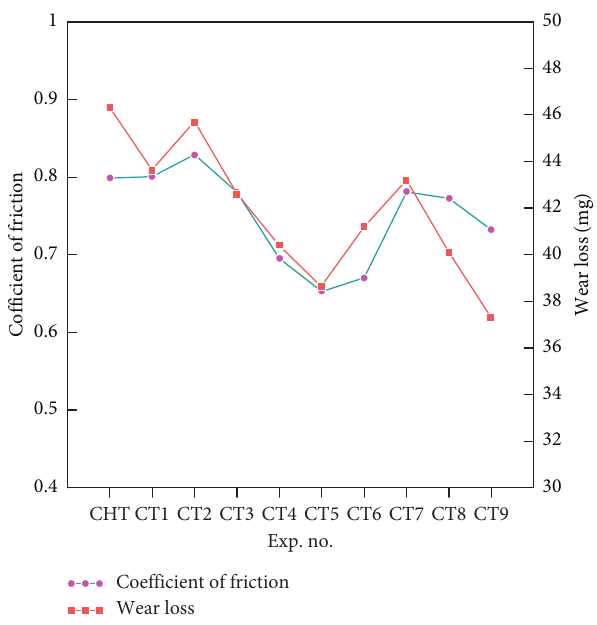
Figure 5: Comparison of average coefficient friction and wear mass loss of CHT and CTs.